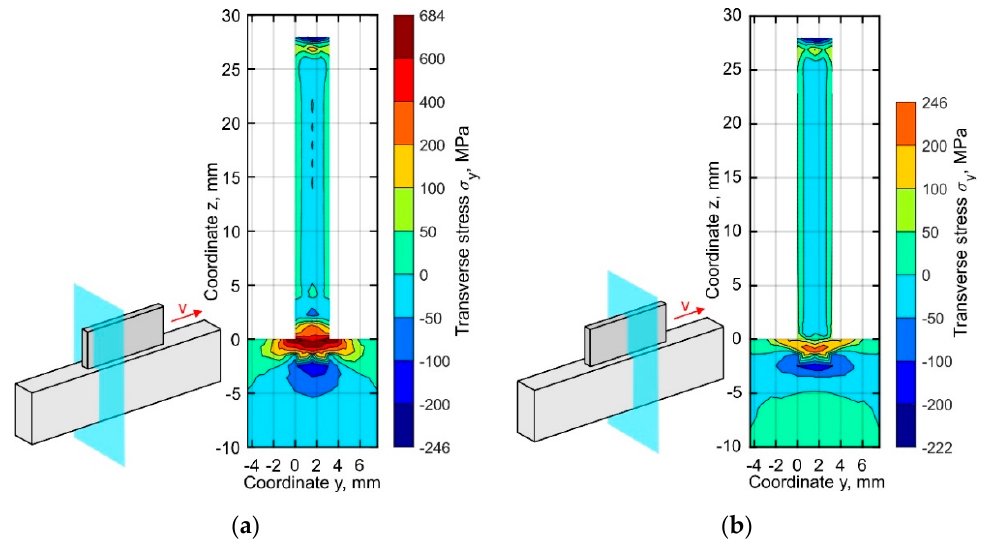
Figure 11. Normal stress distribution in the cross-section ( a – c ) near the buildup end and ( d – f ) in the middle part at the time corresponding to the end of the cooling after ( a , d ) 10, ( b , e ) 25, and ( c , f ) 50 layers.